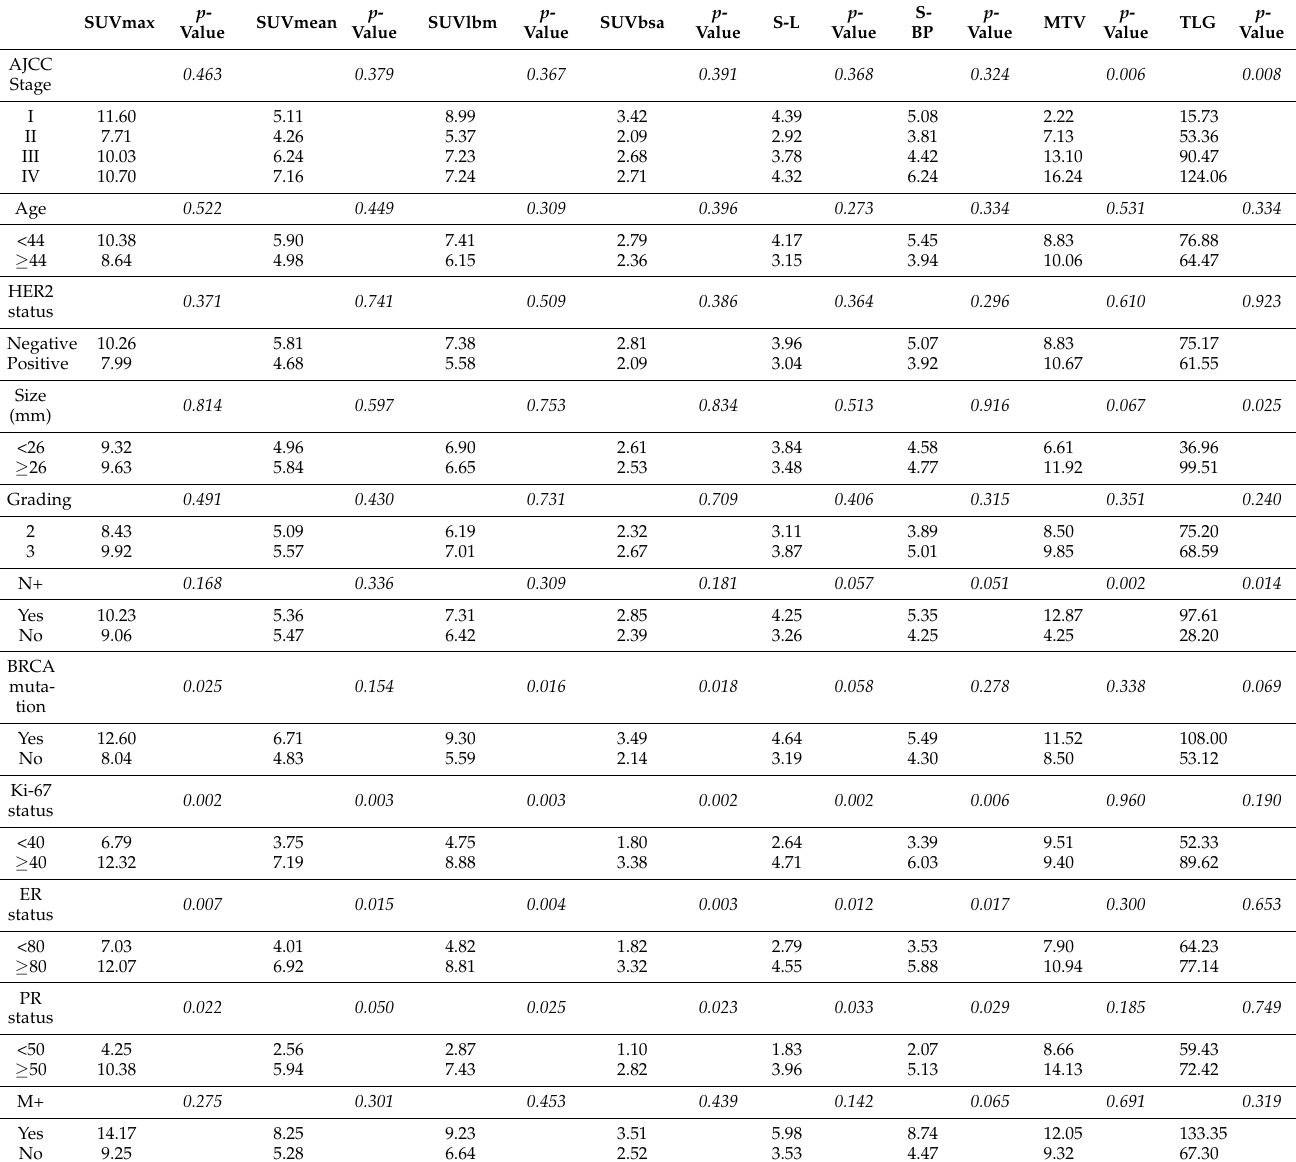
Table 2. Correlation between clinicopathological and baseline [ 18 F]FDG PET/CT semiquan- titative